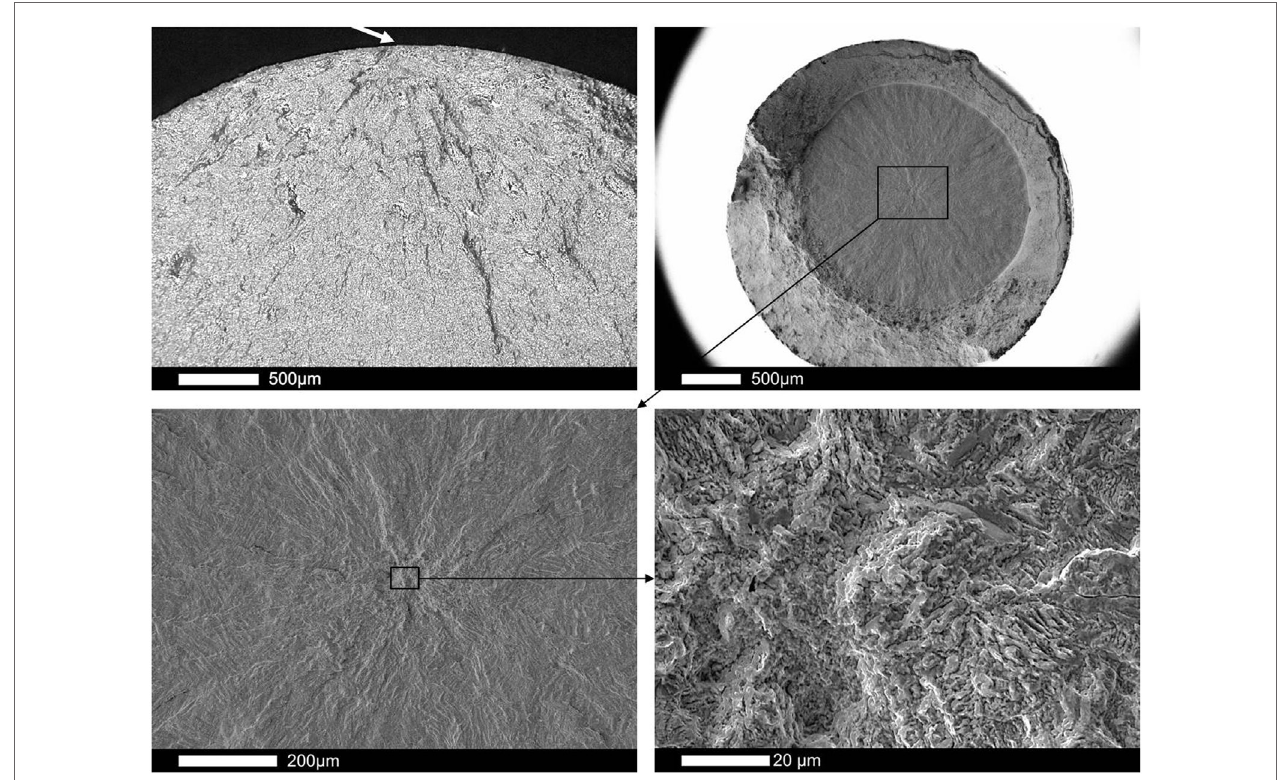
FigUre 8 | crack initiation site for hot-isostatic-pressed specimen under tension–compression loading; surface crack initiation at N f < 10 7 (top left), internal crack initiation at N f = 1.8 × 10 8 (top right), and magnification of internal crack initiation (bottom left and right) .